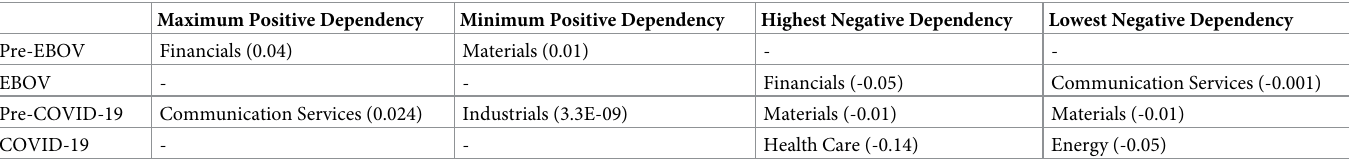
Fig 3. Dependency analysis during episodes. This plot indicates that there is a high negative dependency between IEMV and other sectoral stock market indices during EBOV and COVID-19 periods, but the dependency during the coronavirus outbreak is much higher (https://ndownloader.figshare.com/files/29099883). https://doi.org/10.1371/journal.pone.0259282.g003 Table 8. Summary of dependency on IEMV during